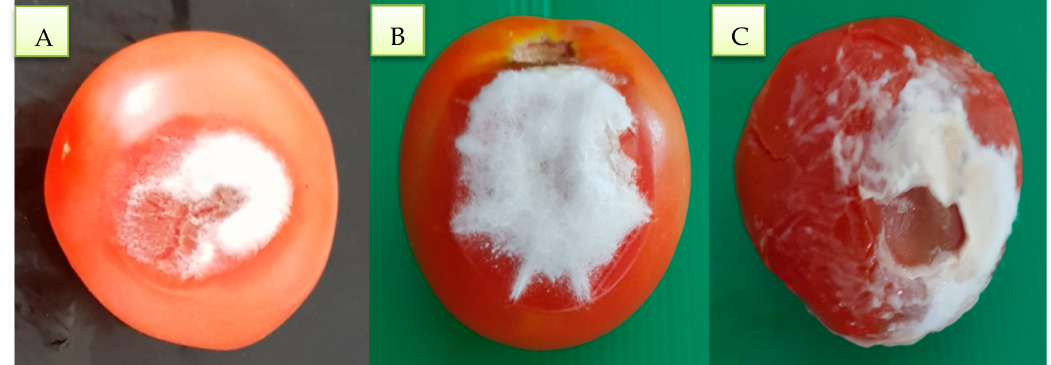
Figure 1. Symptoms of tomato fruit rot: soft and sunken tissue covered by white pinkish mycelium. A —20% severity, B —40% severity, and C —more than 75%